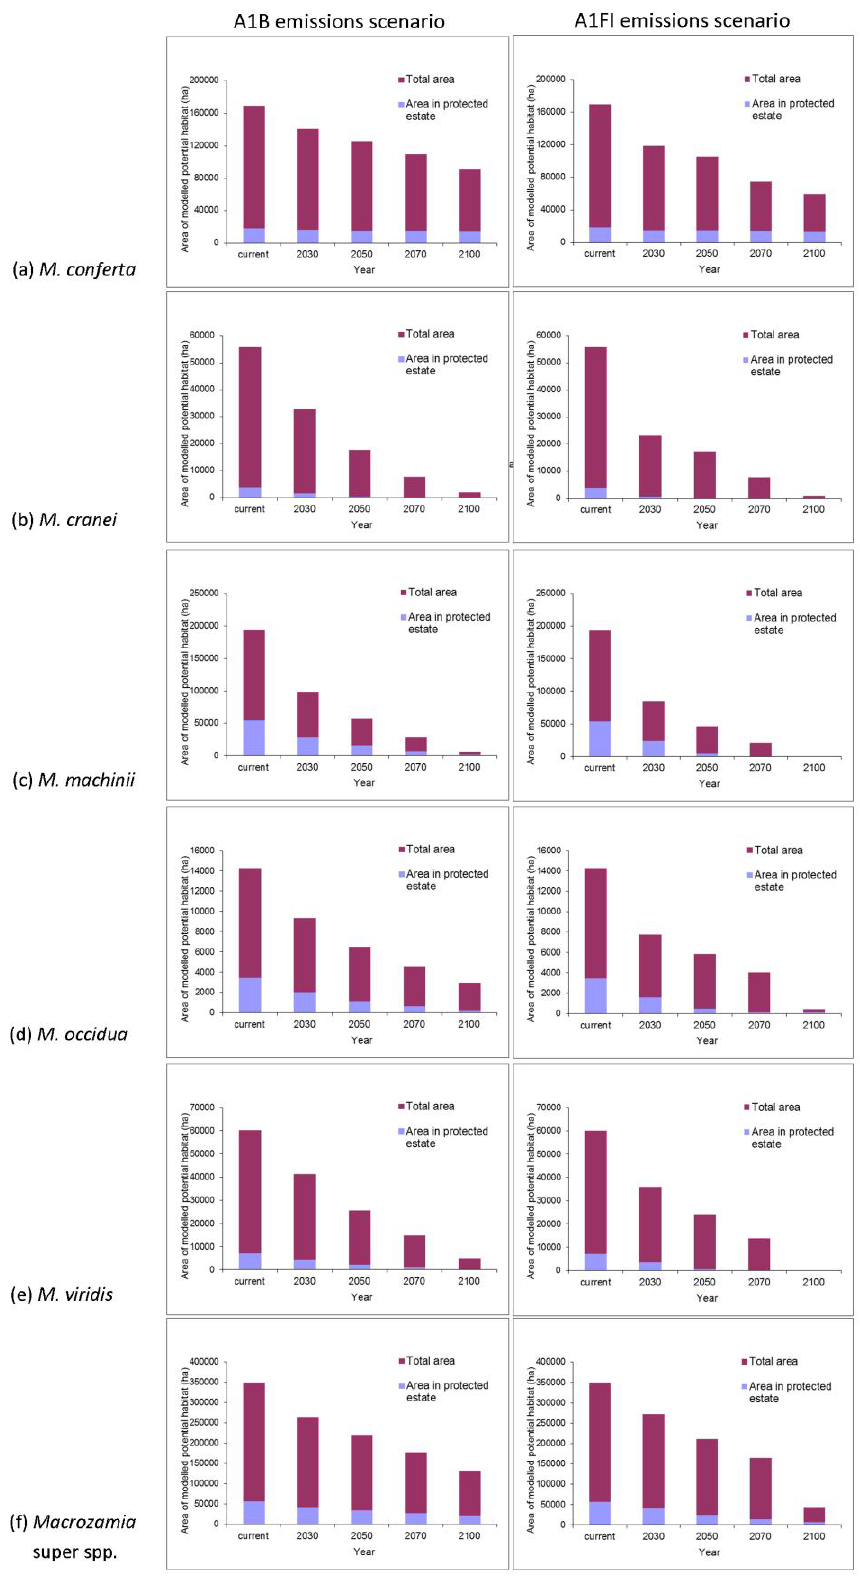
Figure 3. Predicted changes in the total area of potential habitat and area within protected areas of Darling Downs Macrozamia cycads and with increasing annual mean temperature under A1B and A1FI emission scenarios (a) M. conferta , (b) M. cranei , (c) M. machinii , (d) M. occidua , (e) M. viridis and (f) (cid:87)(cid:75)(cid:72)(cid:3)(cid:181)(cid:86)(cid:88)(cid:83)(cid:72)(cid:85)(cid:86)(cid:83)(cid:72)(cid:70)(cid:76)(cid:72)(cid:86)(cid:182)(cid:3) Macrozamia super